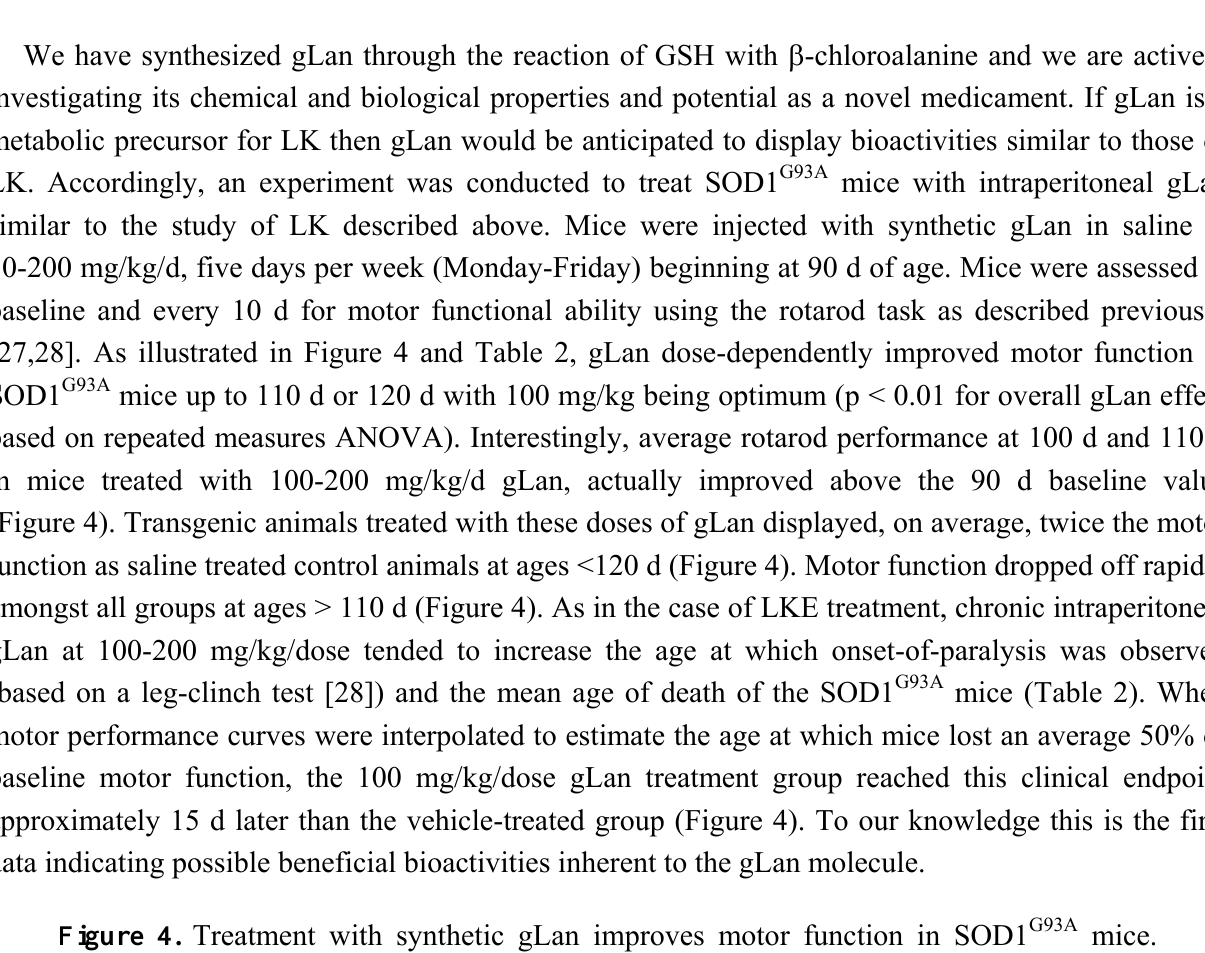
Figure 4. Treatment with synthetic gLan improves motor function in SOD1 G93A